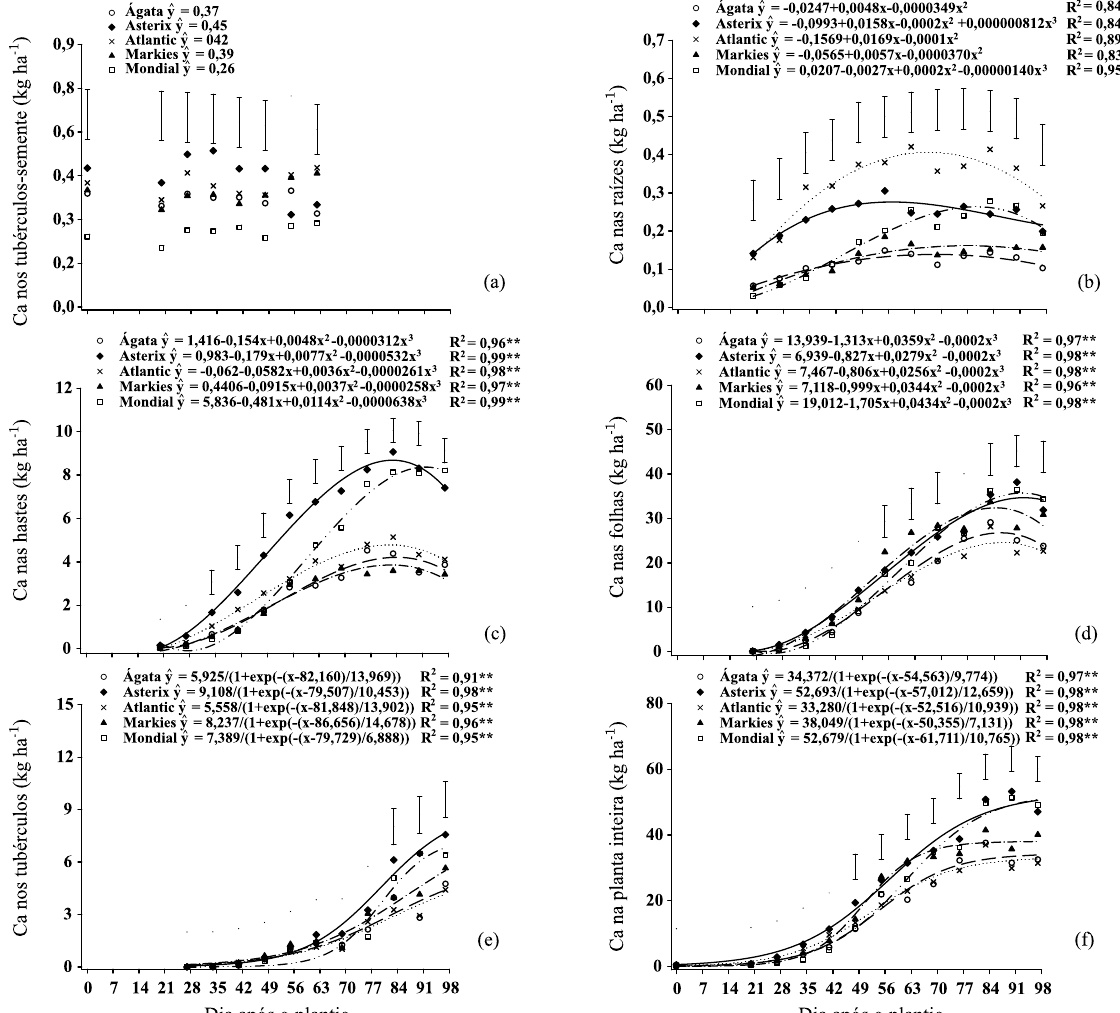
Figura 5. Quantidade de Ca nos tubérculos-semente (a), raízes (b), hastes (c), folhas (d), tubérculos (e) e na planta inteira (f) de cultivares de batata ao longo do ciclo. ** significativo a 1 % pelo teste F. Barras verticais indicam o valor de DMS pelo teste de Tukey a 5